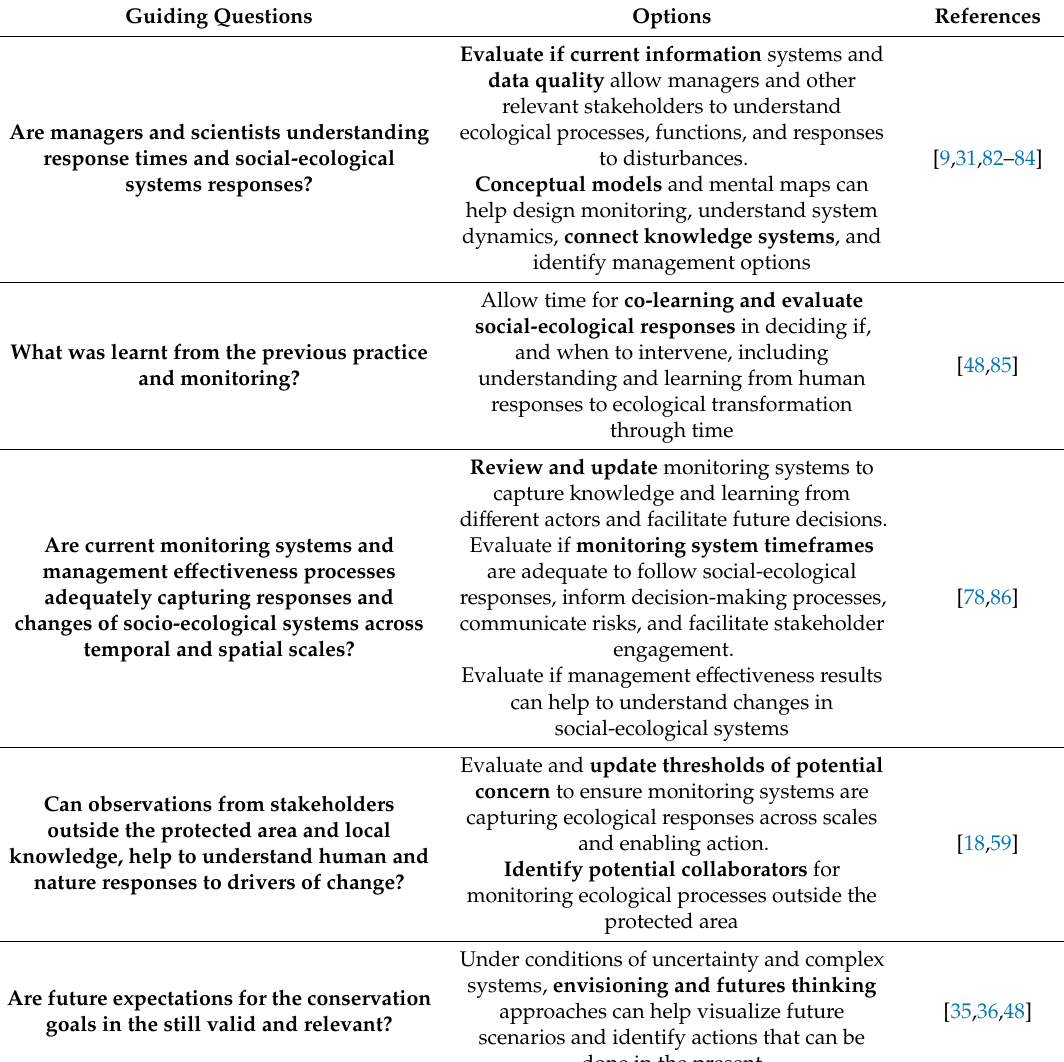
Table A2. Guiding questions for protected area managers to facilitate the reflexivity process in multidimensional knowledge-based processes at the reflexive practice level. Words highlighted in bold represent some key ideas and issues to